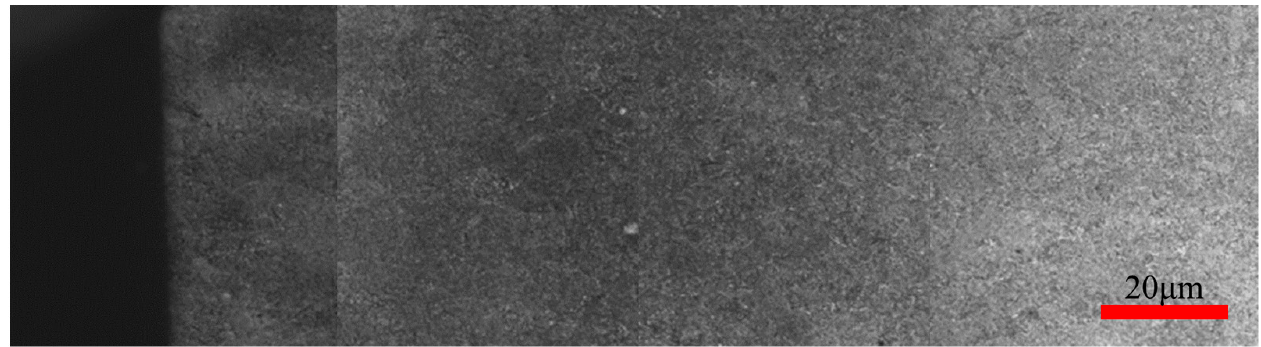
Figure 14. The content of microstructure of different layers.